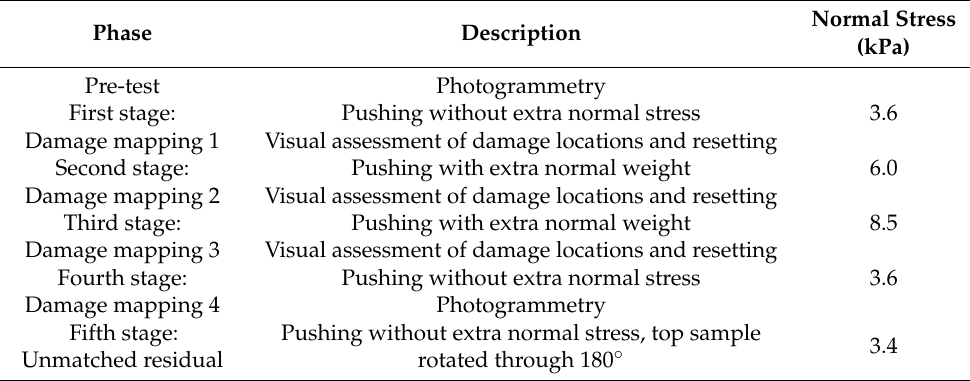
Table 1. Shear test stages and loads used in the large sample shear test.